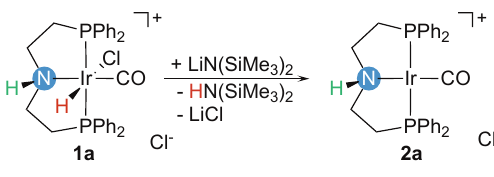
Figure 3. Reactivity of 1a towards